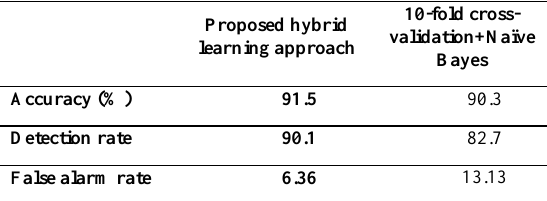
Table 6. Comparison between accuracy and detection rate.